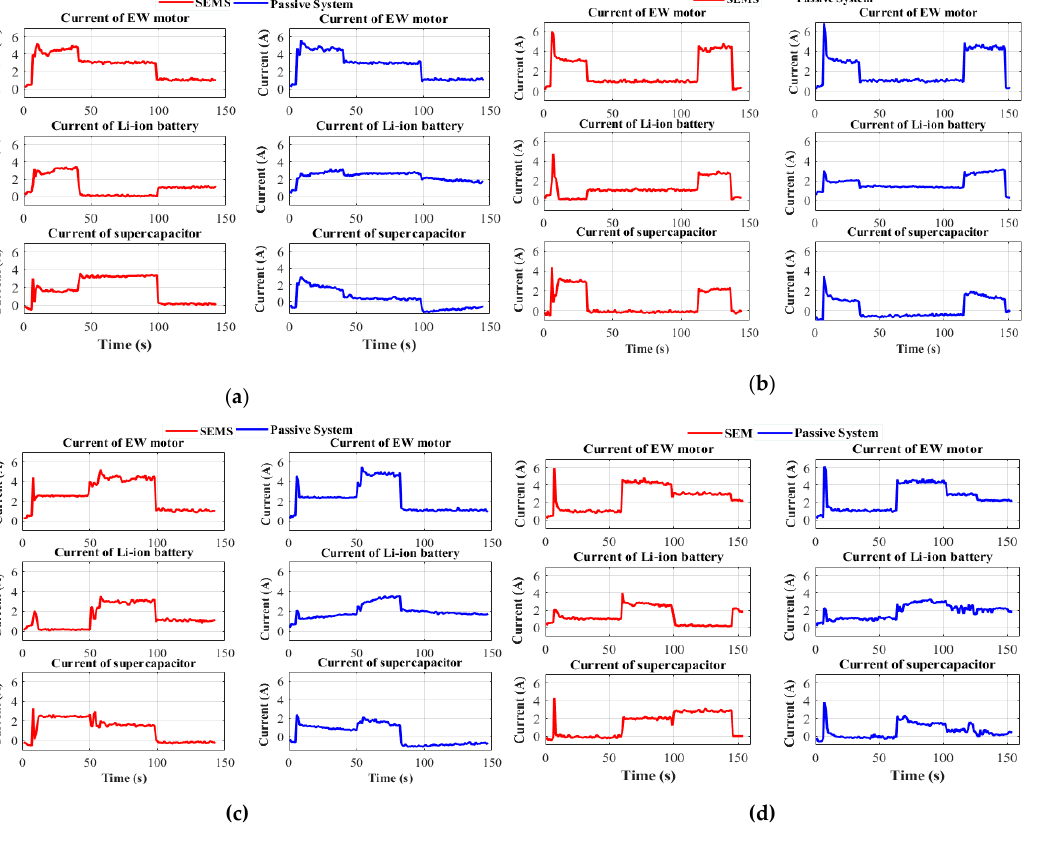
Figure A1. Comparison of the proposed SEMS and P-HESS during different modes: ( a ) start–high climbing–low climbing–plain; ( b ) start–low climbing–plain–high climbing; ( c ) start–low climbing–high climbing–plain; ( d ) start–plain–high climbing–low climbing.